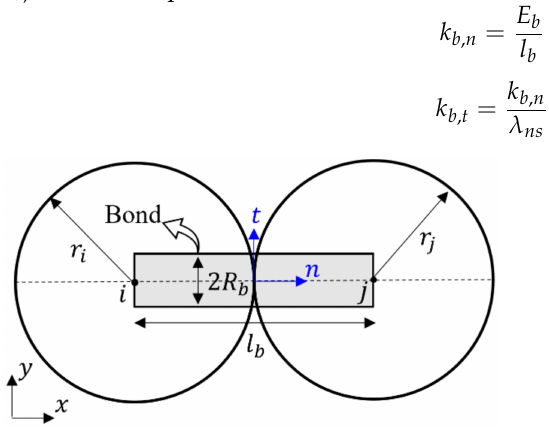
Figure 1. Two particles connected with a